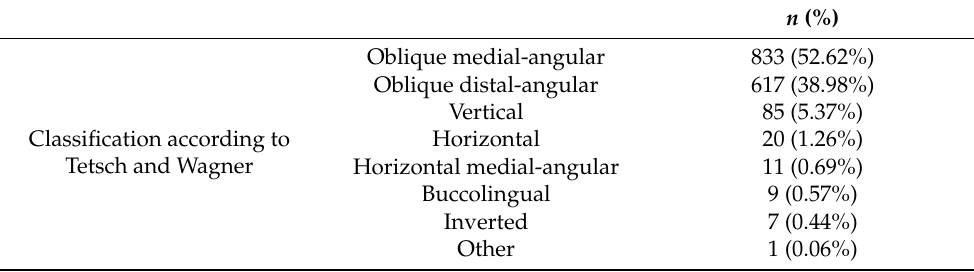
Table 5. Frequency of impaction degrees among impacted mandibular third molars according to Tetsch and Wagner in the study